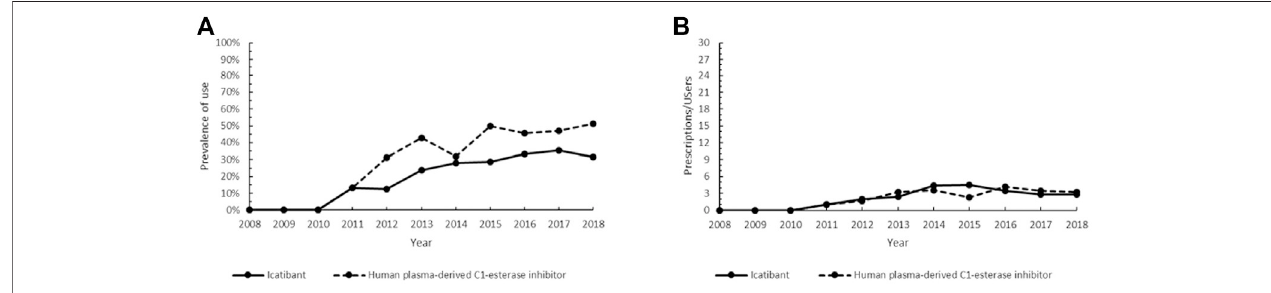
FIGURE 4 | Trend of the prevalence (graph (A) ) and intensity of use (graph (B) ) of the orphan drug icatibant and the human plasma-derived C1-esterase inhibitor indicated for hereditary angioedema. Prevalence of use: ratio between the number of cases with at least one prescription and the number of prevalent cases at the